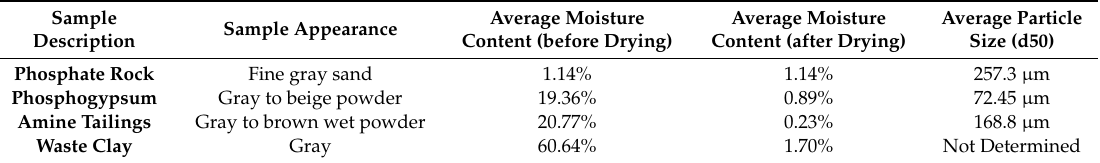
Table 2. Physical Characteristics of Phosphate Rock and Phosphoric Acid Waste By-Products.